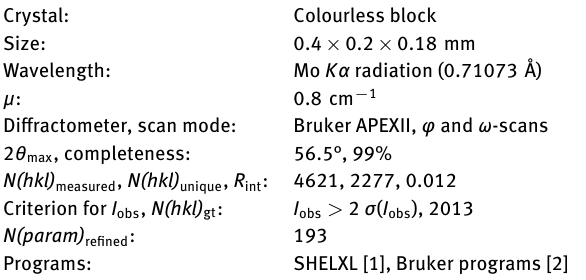
Table 2: Fractional atomic coordinates and isotropic or equivalent isotropic displacement parameters (Å 2